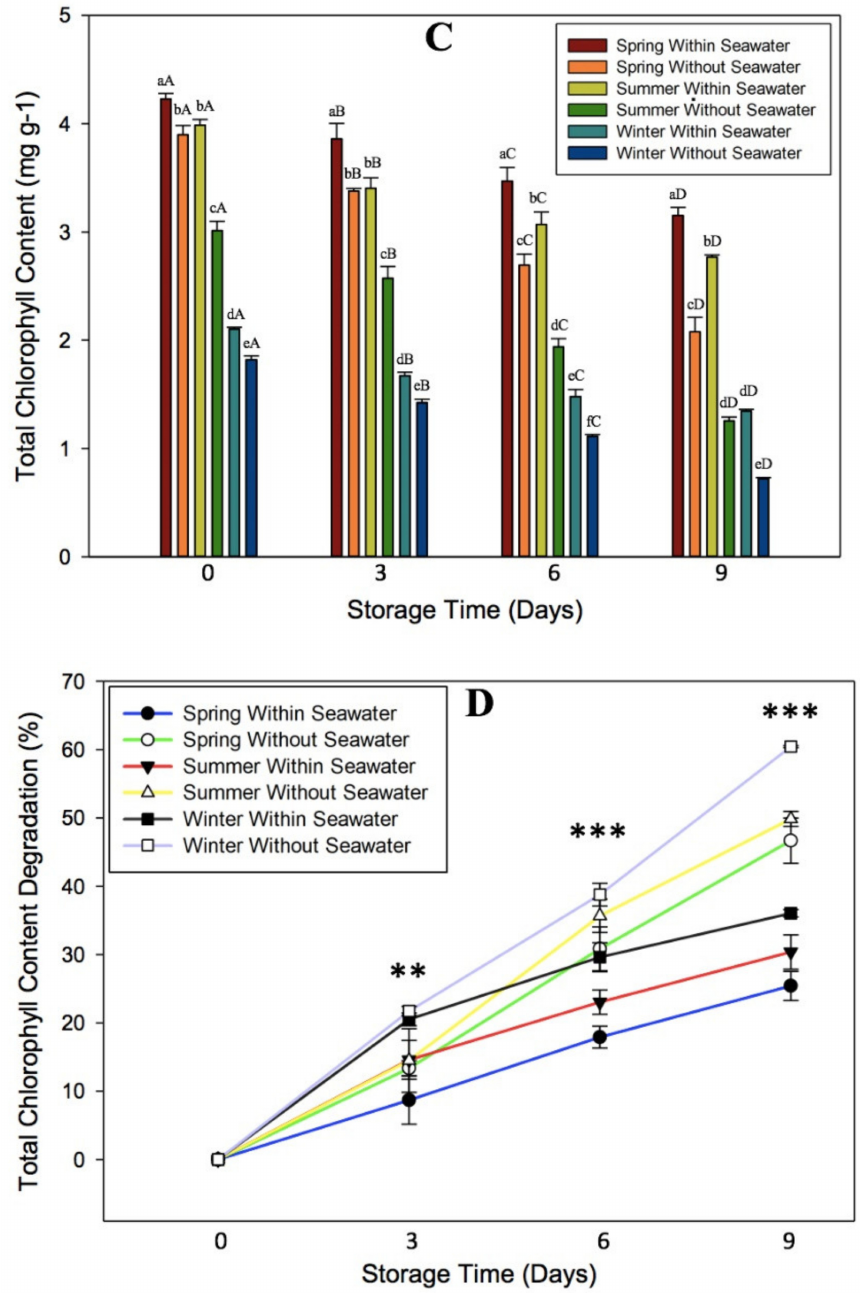
Figure 5. Oxidative stress effect on chlorophyll content of seagrape in different seasons during post- harvest storage ( A ) chlorophyll a content ( B ) chlorophyll a degradation rates ( C ) total chlorophyll content ( D ) total chlorophyll content degradation rates. The data express means ( n = 3) with the error bar shows standard deviation. a–f Means express the significant differences in the same storage time ( p < 0.05). A–D Means express the significant differences in the same treatment ( p < 0.05). The star marks express the significant differences as respectively ** ( p < 0.01), and *** ( p <